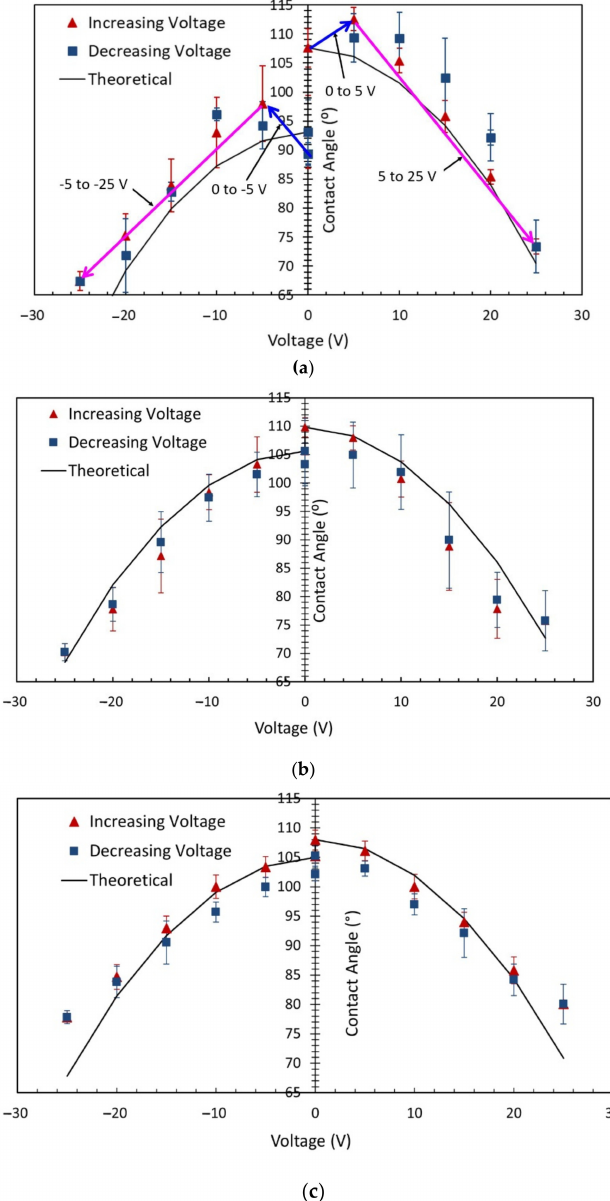
Figure 4. Sessile-drop electrowetting with ( a ) DC voltage and the bare ground electrode, ( b ) DC voltage and Cytop-coated ground electrode, and ( c ) AC voltage and the bare ground